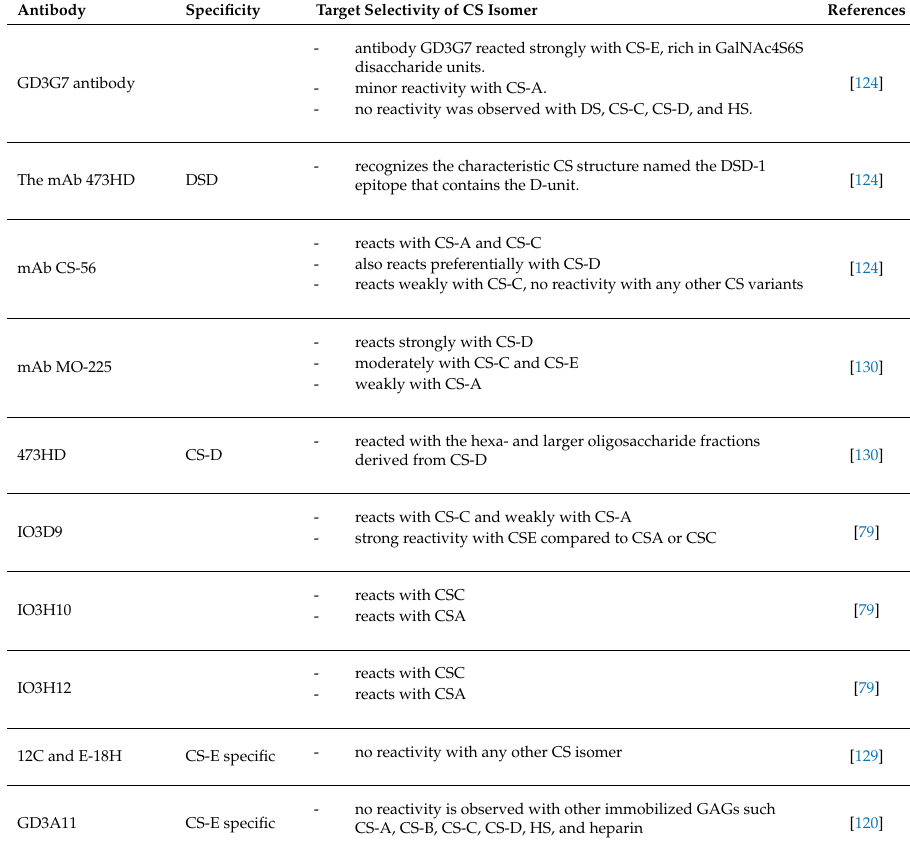
Table 4. Various antibodies used to target their respective CS